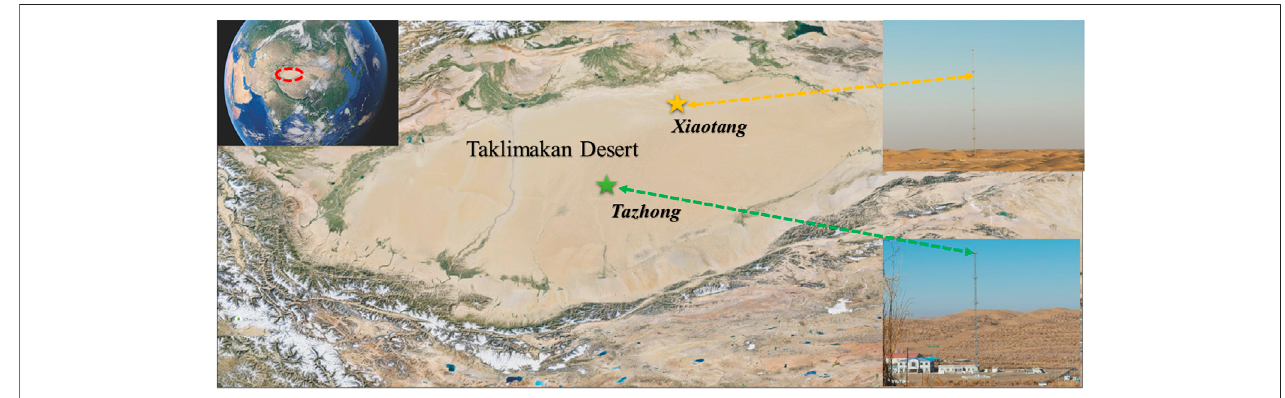
FIGURE 1 | Locations of the main station (TZ) and auxiliary station (XT) in the Taklimakan Desert and images of the fl ux observation